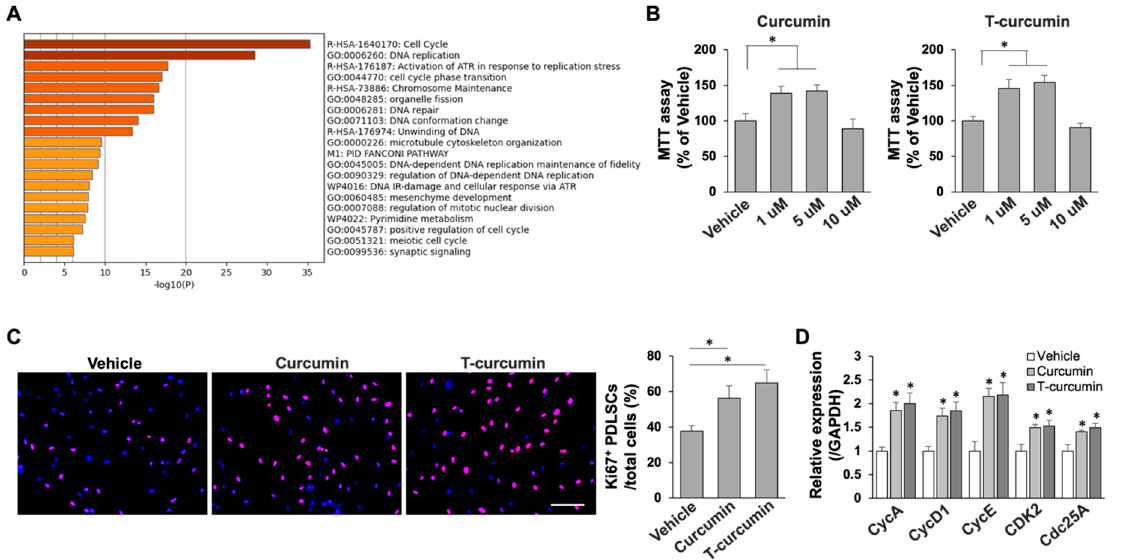
Figure 2. Curcumin elevated PDLSC proliferation. ( A ) Curcumin significantly activated cell cycle and cell proliferation pathways in PDLSCs by GO enrichment analysis. ( B ) MTT assay showed that curcumin treatment promoted PDLSC viability. ( C ) Immunofluorescence cellular staining by using Ki67 antibody showed that curcumin treatment greatly elevated Ki67 + cell percentage compared to vehicle treated group. Scale bar, 25 μ m. ( D ) qPCR analysis showed that the levels of cell cycle genes were significantly elevated with curcumin treatment in PDLSCs. * p < 0.005. PDLSCs in passage 3 were used in all the assays. All experiments were at least repeated three times. Error bars represent the s.d. from the mean values.